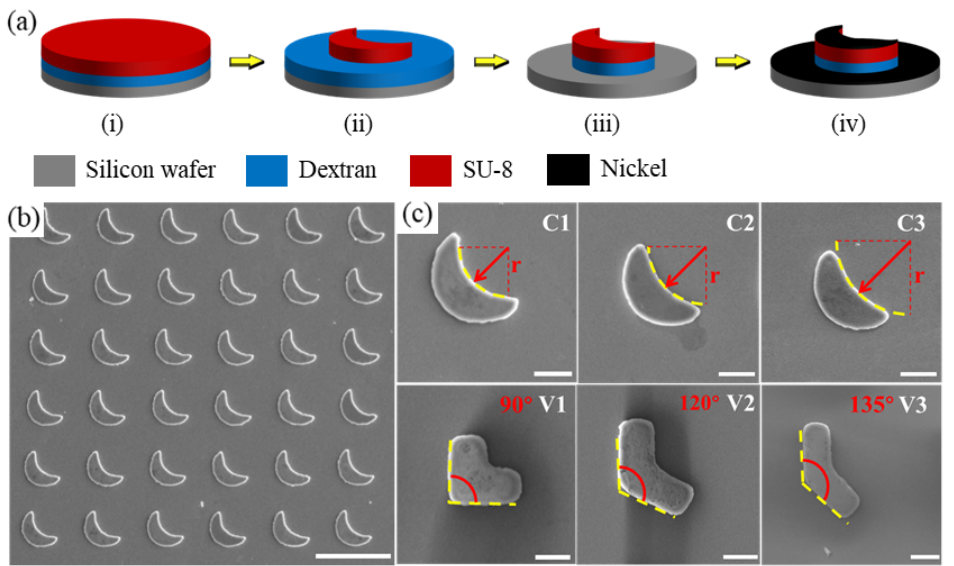
Figure 1. Fabrication process and geometrical design of crescent-shaped and V-shaped achiral microswimmers. ( a ) Illustration of the fabrication process of achiral microswimmers through pho- tolithography. ( b ) Batch production of crescent-shaped microswimmers by photolithography. Scale bar: 100 µ m. ( c ) C1, C2, and C3 are crescent-shaped microswimmers with different curvatures of the inner circle; V1, V2, and V3 are V-shaped microswimmers with different arm angles. Scale bars in ( c ): 20 µ